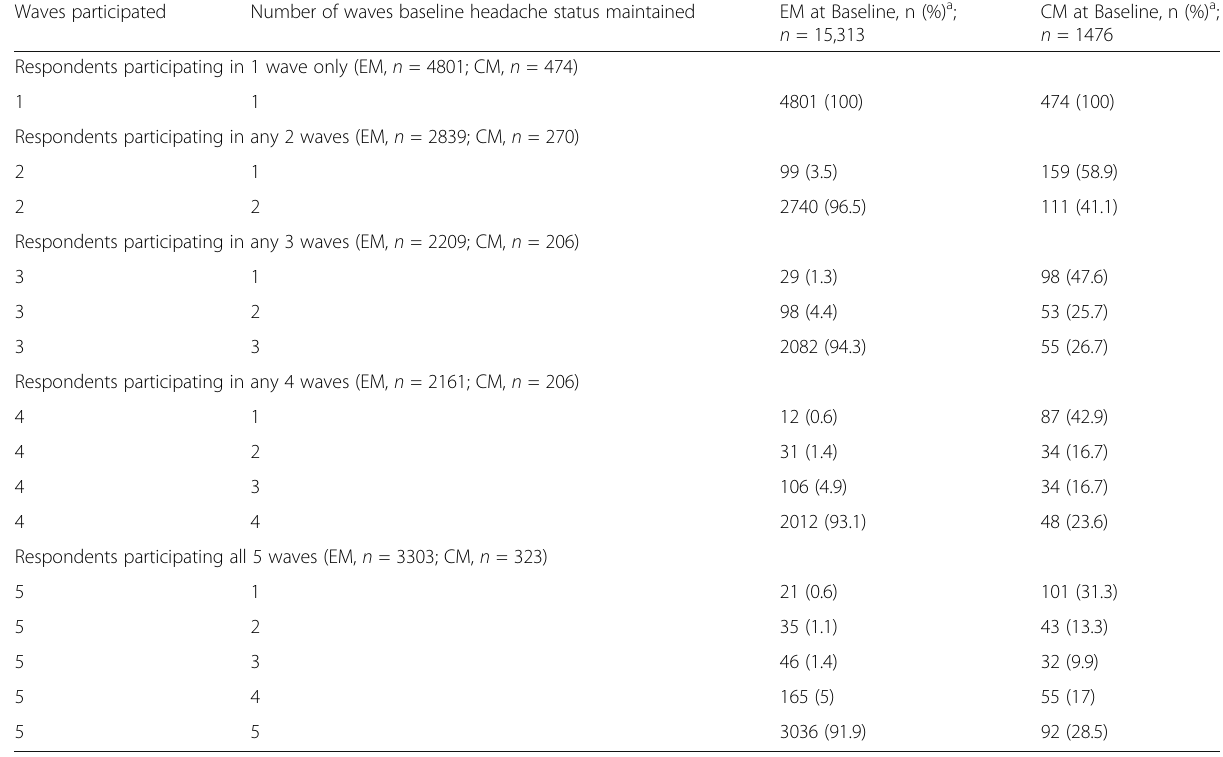
Table 1 Baseline headache status stability stratified on waves of study participation Waves participated